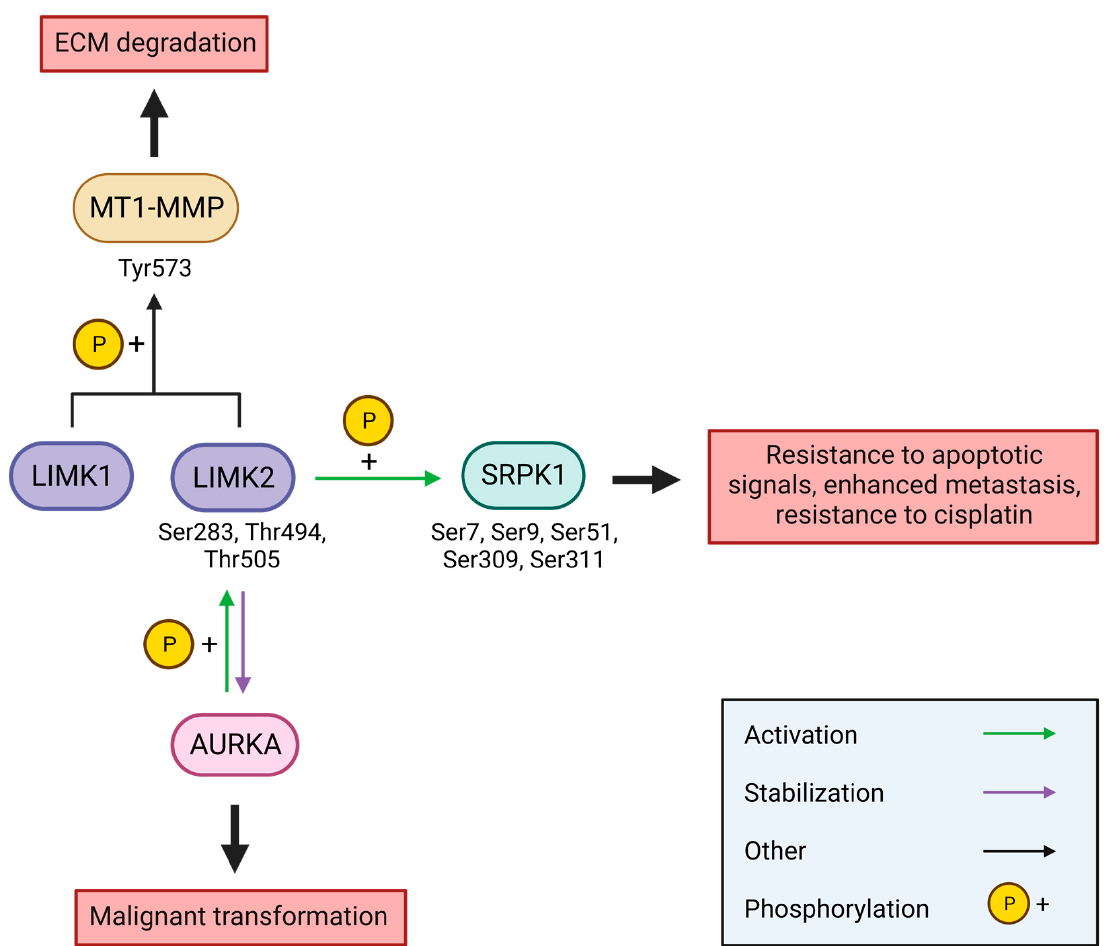
Figure 5. LIM kinases molecular implication in breast cancer. LIMK2 sites phosphorylated by AURKA are mentioned (Ser283, Thr494, and Thr505), as well as SRPK1 sites phosphorylated by LIMK2 (Ser7, Ser9, Ser51, Ser309, and Ser311), and MT1-MMP site phosphorylated by LIMK1 and LIMK2 (Tyr573).